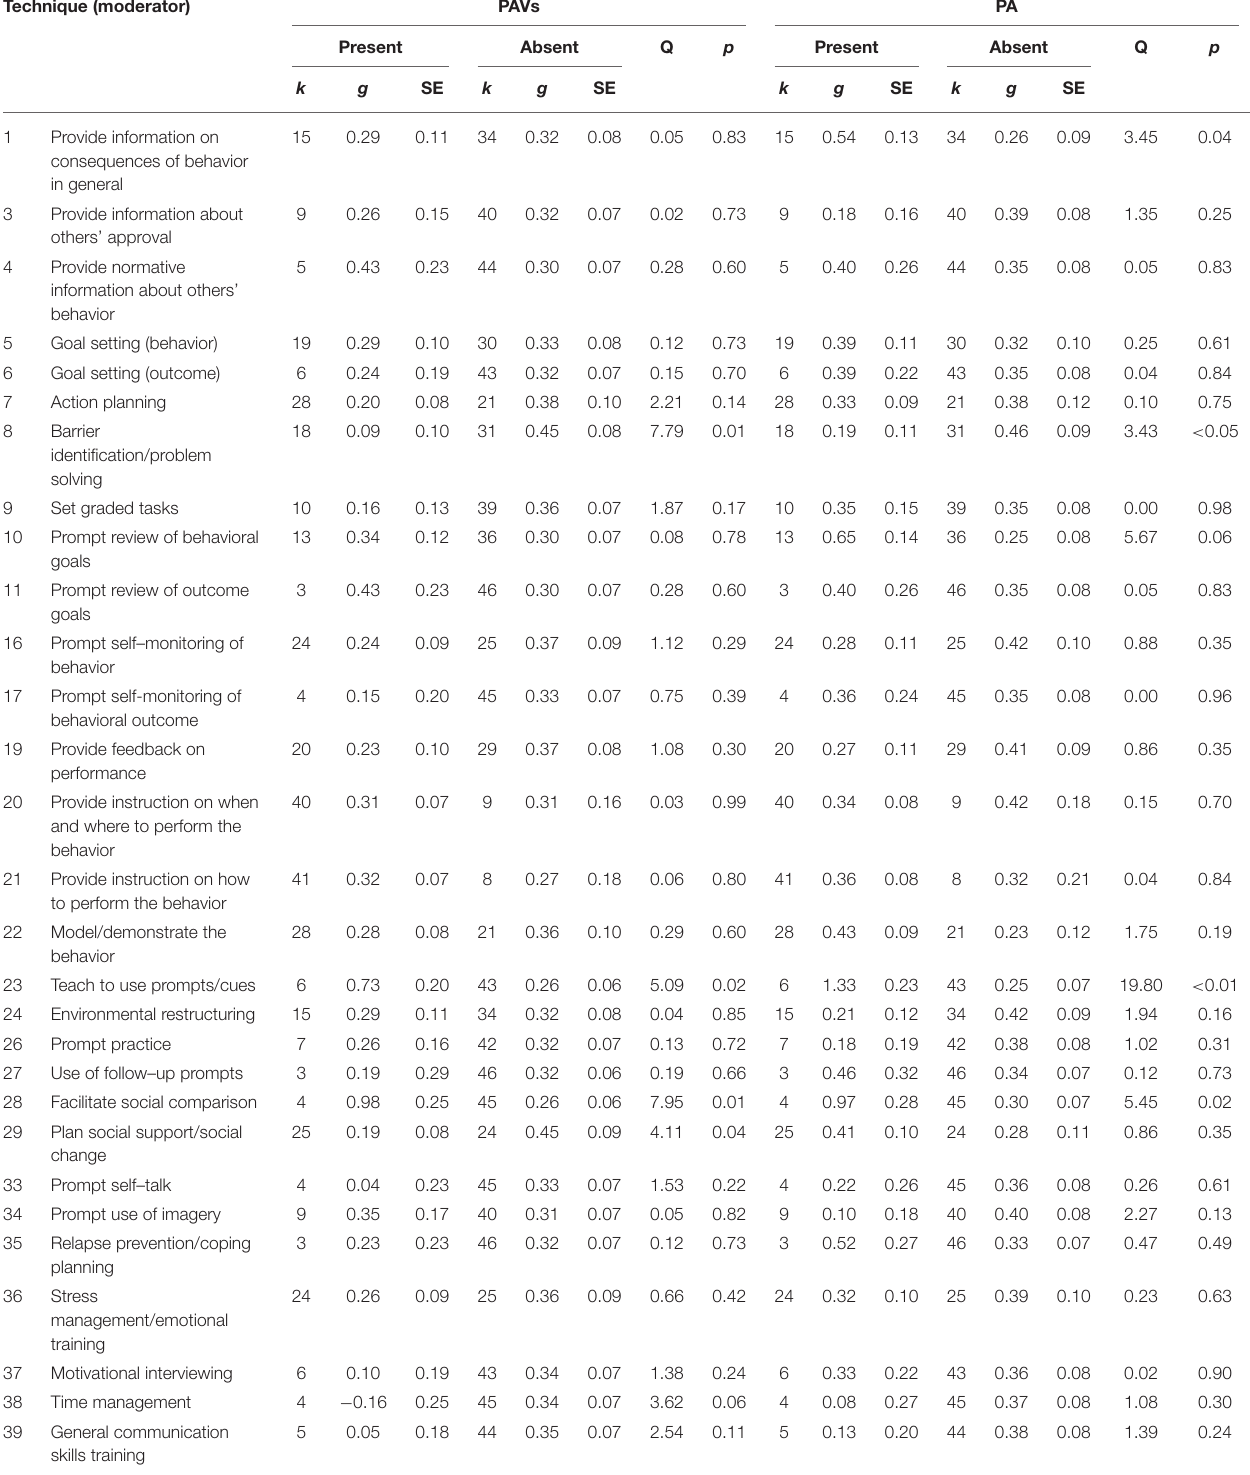
TABLE 4 | Comparison between PAVs and PA, according to whether a specific technique is present or absent in the intervention. Technique